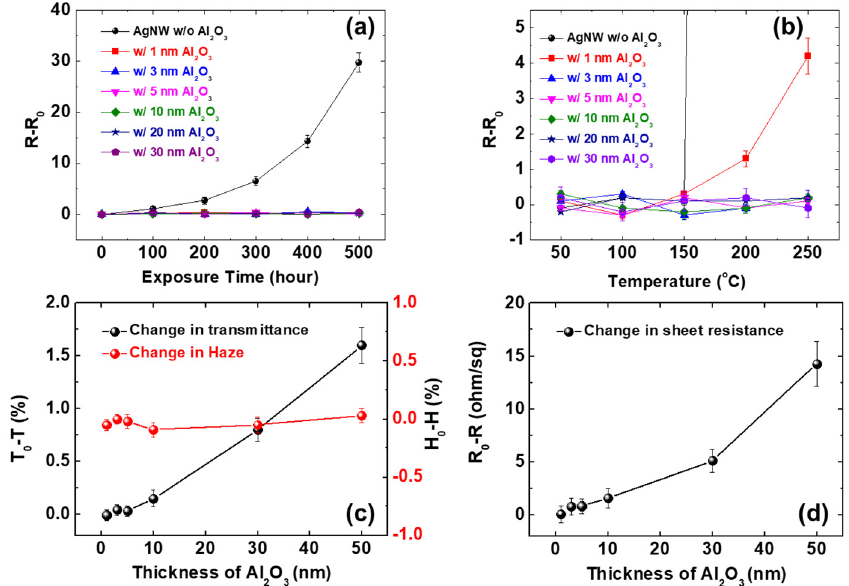
Figure 19. Resistance change of silver nanowire networks with and without Al 2 O 3 as a function of ( a ) different exposure time at 85 ◦ C and ( b ) different annealing temperature. Change in ( c ) transmittance and haze and ( d ) sheet resistance of silver nanowire networks with different Al 2 O 3 coating thickness. Reproduced with permission from ref. [52]. Copyright 2019, Elsevier.